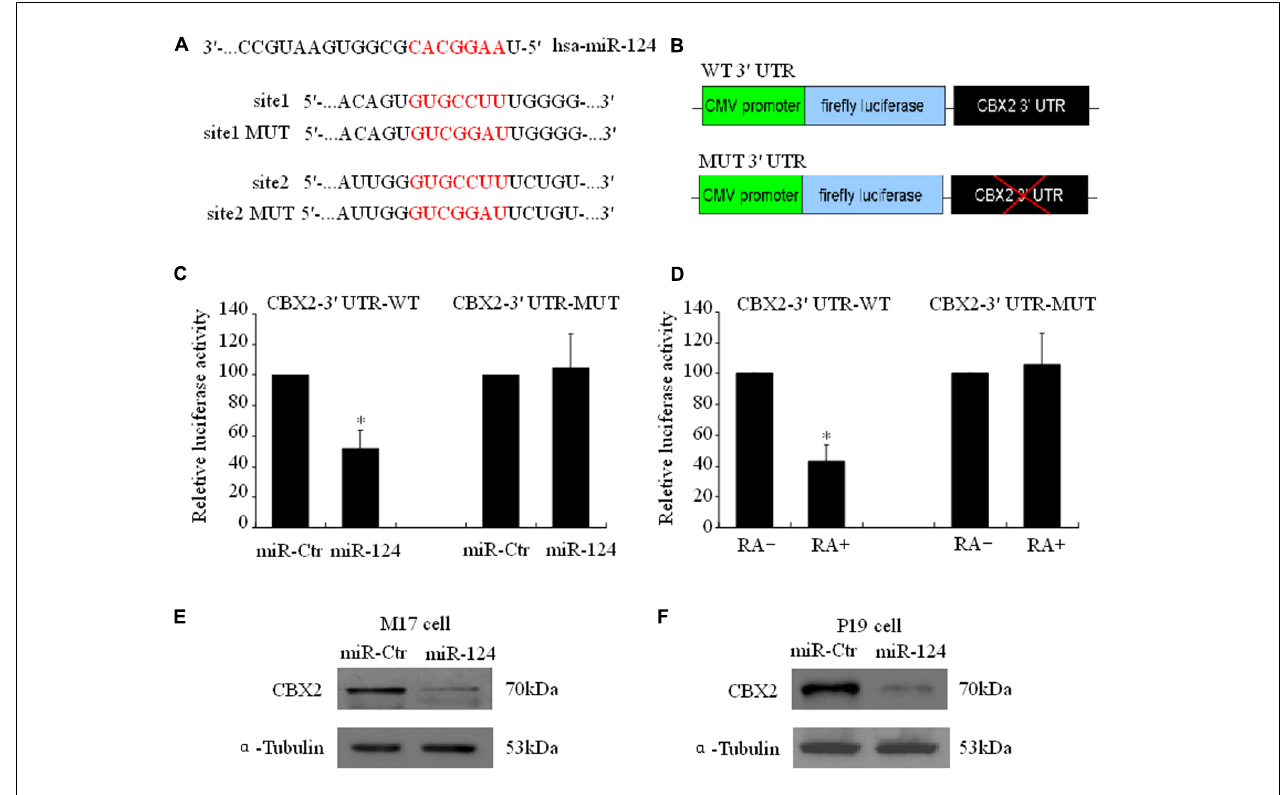
FIGURE 3 | CBX2 mRNA is a direct target of miR-124. (A) Predicted configurations of duplex formations between miR-124 and its target sites in the 3 (cid:48) UTR of CBX2. (B) Schematic representation of human CBX2 3 (cid:48) UTR, with wild-type (WT) or mutated (MUT) miR-124 binding sites, subcloned to the downstream of PGL3 firefly luciferase reporter plasmid. (C) Quantification of reporter activity after transfection of the indicated constructs in M17 cells. The data are presented as mean ± SD, n = 3 independent experiments, ∗ P < 0.05. (D) Quantification of reporter activity 5 days after transfection of the indicated constructs in RA treated or untreated M17 cells. The data are presented as mean ± SD, n = 3 independent experiments, ∗ P < 0.05. Immunoblot shows that miR-124 induces a decrease in CBX2 protein levels in both M17 cells (E) and P19 cells (F)